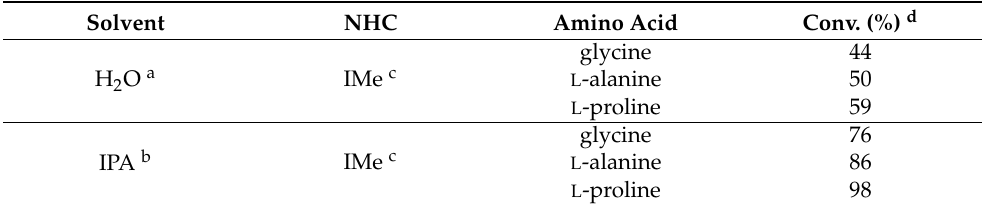
Table 3. Initial catalytic results for the reduction of acetophenone. All trials were carried out using 2.5 mol% of catalyst at 80 °C over a period of 24